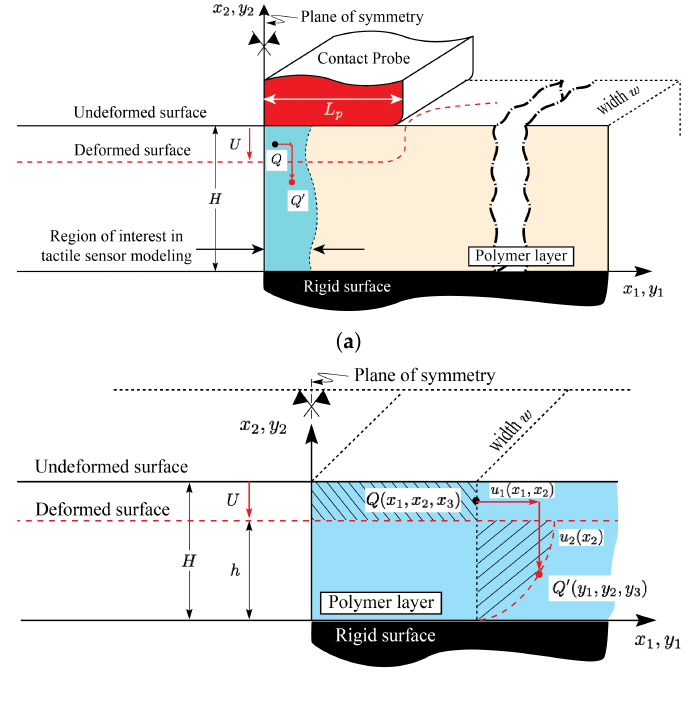
Figure 3. ( a ) A schematic of a boundary value problem associated with the finite flat indentation case. The region of interest in the tactile sensor modeling, in the vicinity of the symmetry plane, is highlighted; ( b ) Magnified view of the highlighted region in ( a ) which can be modeled as the uniform compression case. For clarity, the conductive features are not